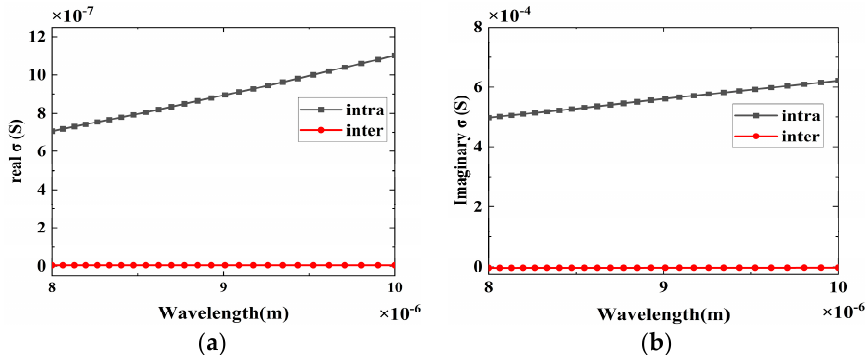
Figure 1. Real ( a ) and imaginary ( b ) parts of interband and intraband conductivity of graphene surface as a function of wavelength at µ c = 1 eV.